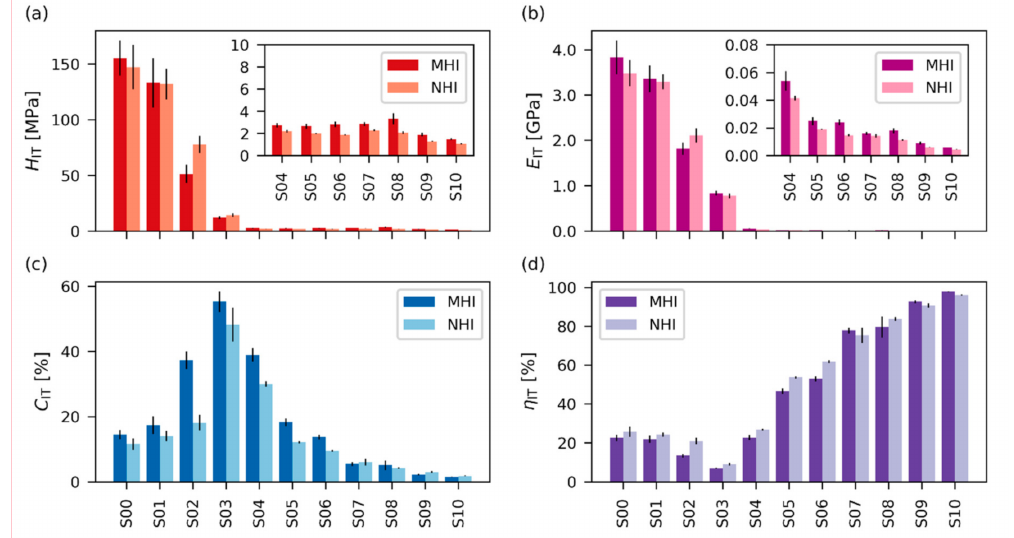
Figure 5. Results of quasistatic experiments: quasistatic instrumented microindentation (MHI) and quasistatic instrumented nanoindentation (NHI): ( a ) indentation hardness, H IT , ( b ) indentation modulus ( E IT ), ( c ) indentation creep ( C IT ), and ( d ) elastic part of the indentation work, η IT